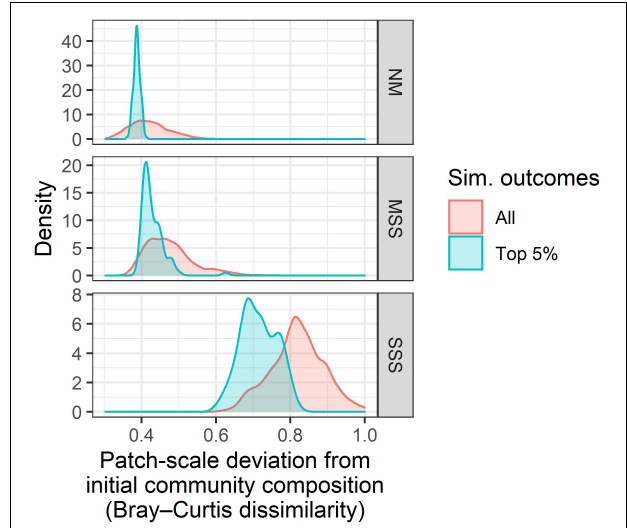
FIGURE 7 | The distribution of patch-scale temporal beta-diversity ( x -axis) for all simulations ( red ) and the top 5% most plausible simulations (blue) for each metacommunity type: neutral model (NM, top ), moderate species sorting (MSS, middle ), and strong species sorting (SSS, bottom ). Patch-scale temporal beta-diversity was quantified for each simulation as the median of the Bray–Curtis dissimilarities between the initial and final ( t = 100) time steps at each patch, using Hellinger transformed